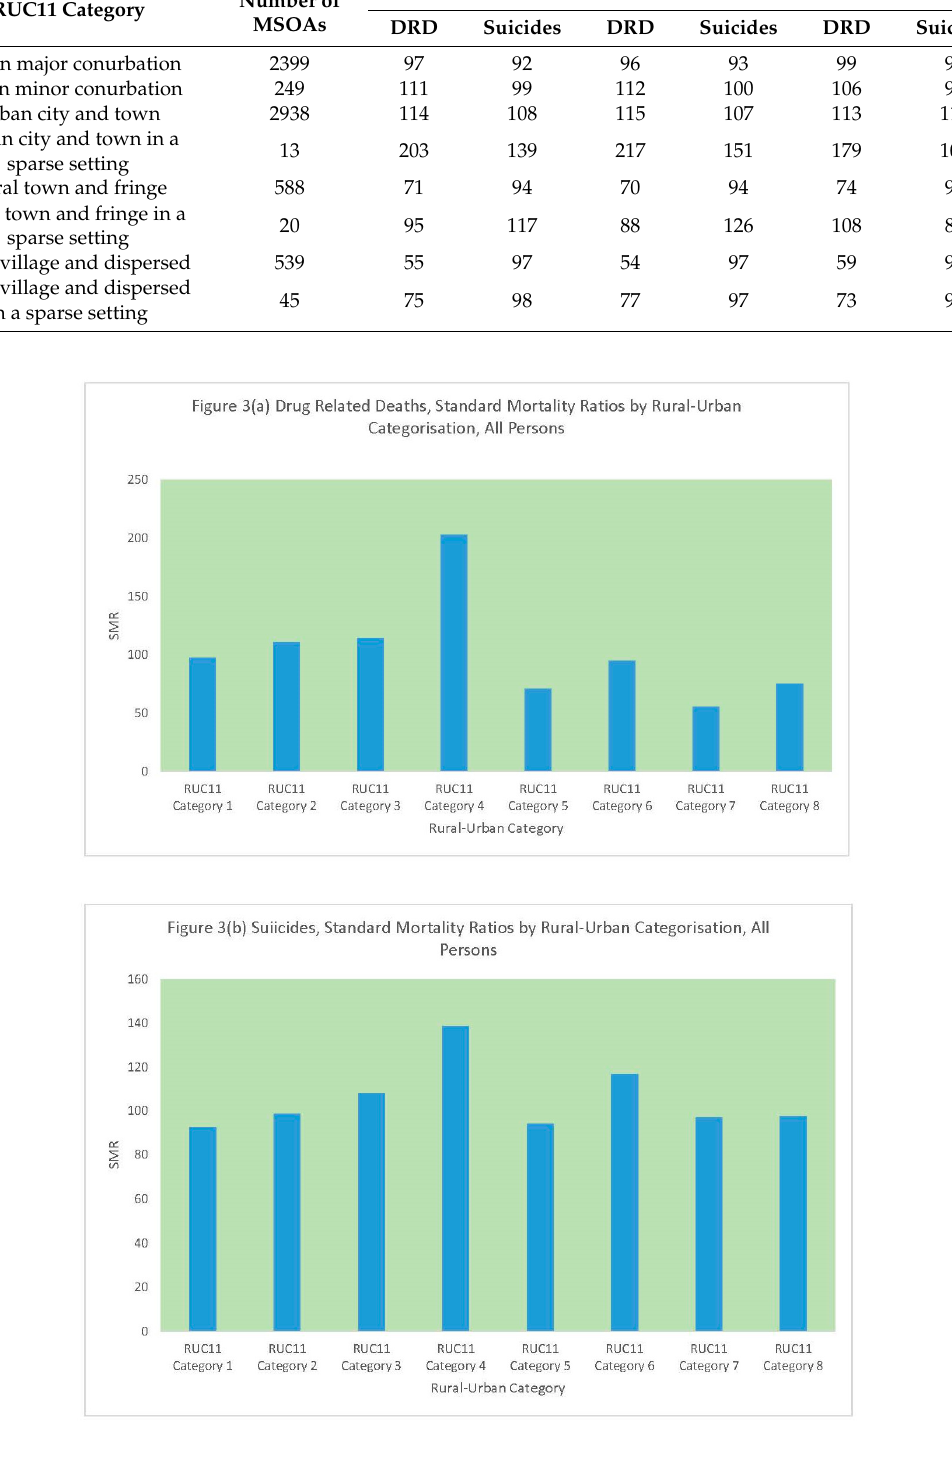
Figure 3. ( a ) DRD SMRs by MSOA Rural-Urban Category, ( b ) Suicide SMRs by MSOA Rural-Urban